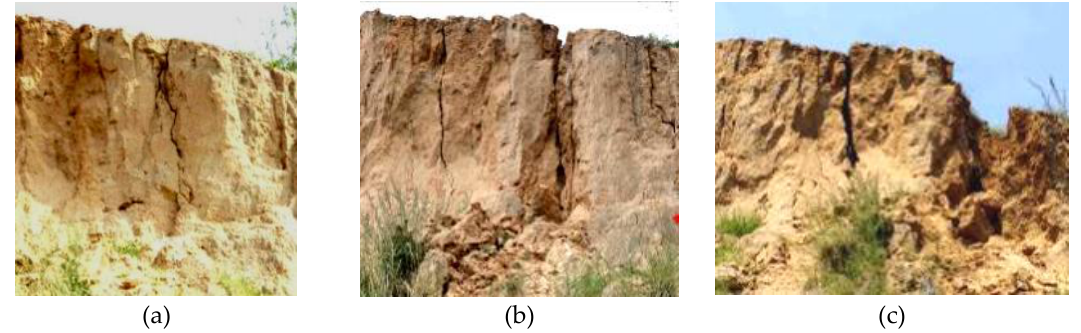
Figure 17. Field measurement of DPC: ( a ) the upper seam working face has mined finished, ( b ) the lower seam working face has finished with the same location, and ( c ) the lower seam working face has advanced through the position of DPC.